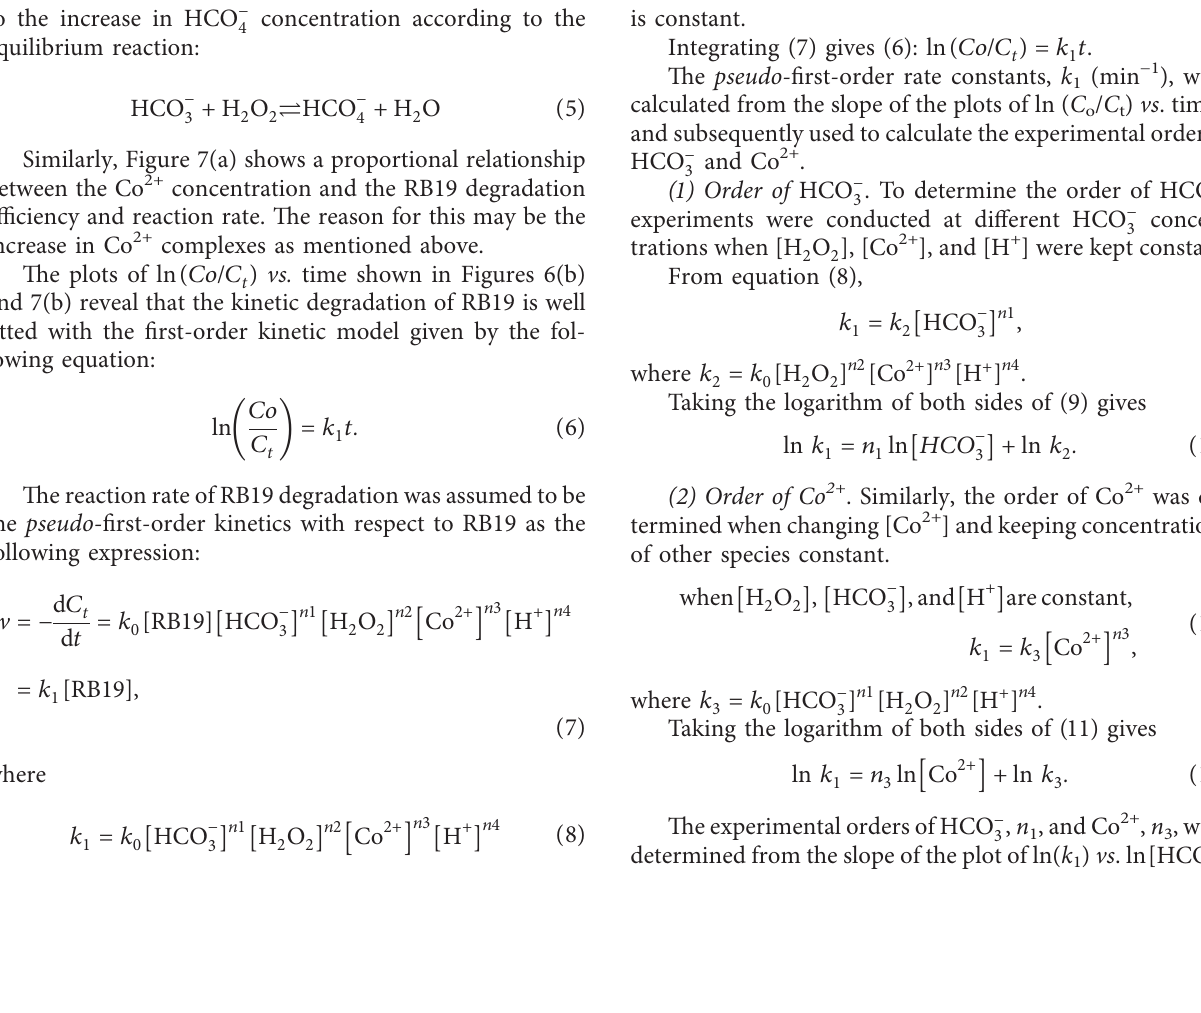
concentrations and 40mM H 3